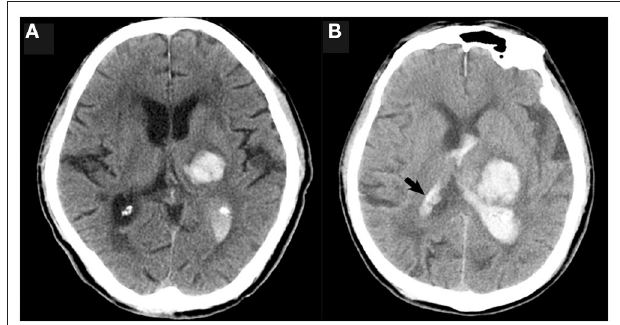
FIGURE 3 | The initial NCCT showed that the thalamic hematoma broke into the ipsilateral ventricle only (A) ; a follow-up NCCT (B) showed new hematoma formation in both the ipsilateral and contralateral ventricles (black